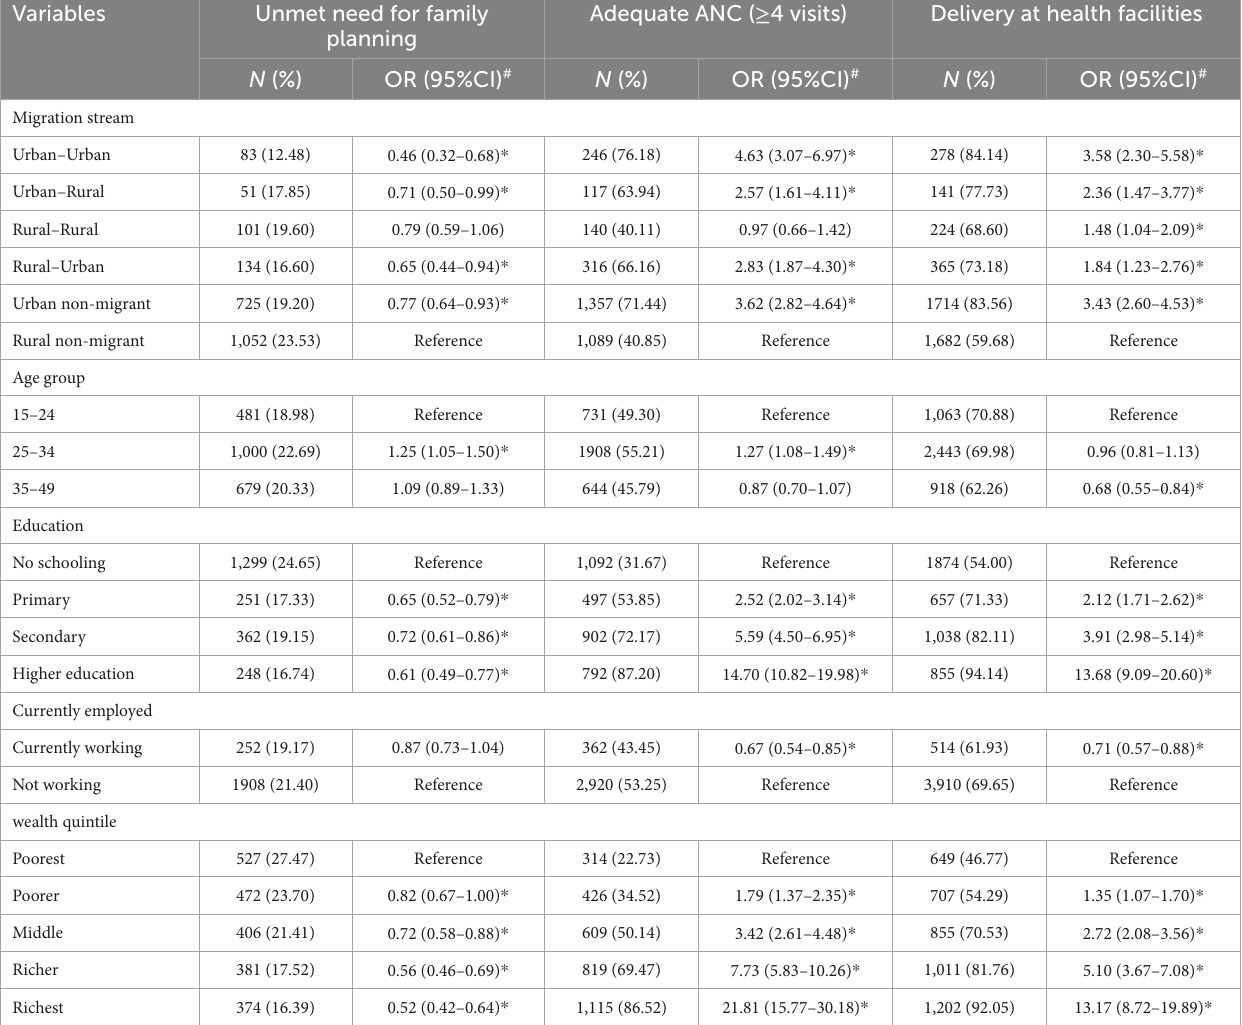
TABLE 2 The distribution and likelihood of the unmet need for family planning, adequate ANC, and delivery at health facilities across migration streams and sociodemographic characteristics among married women aged 15–49 in PDHS